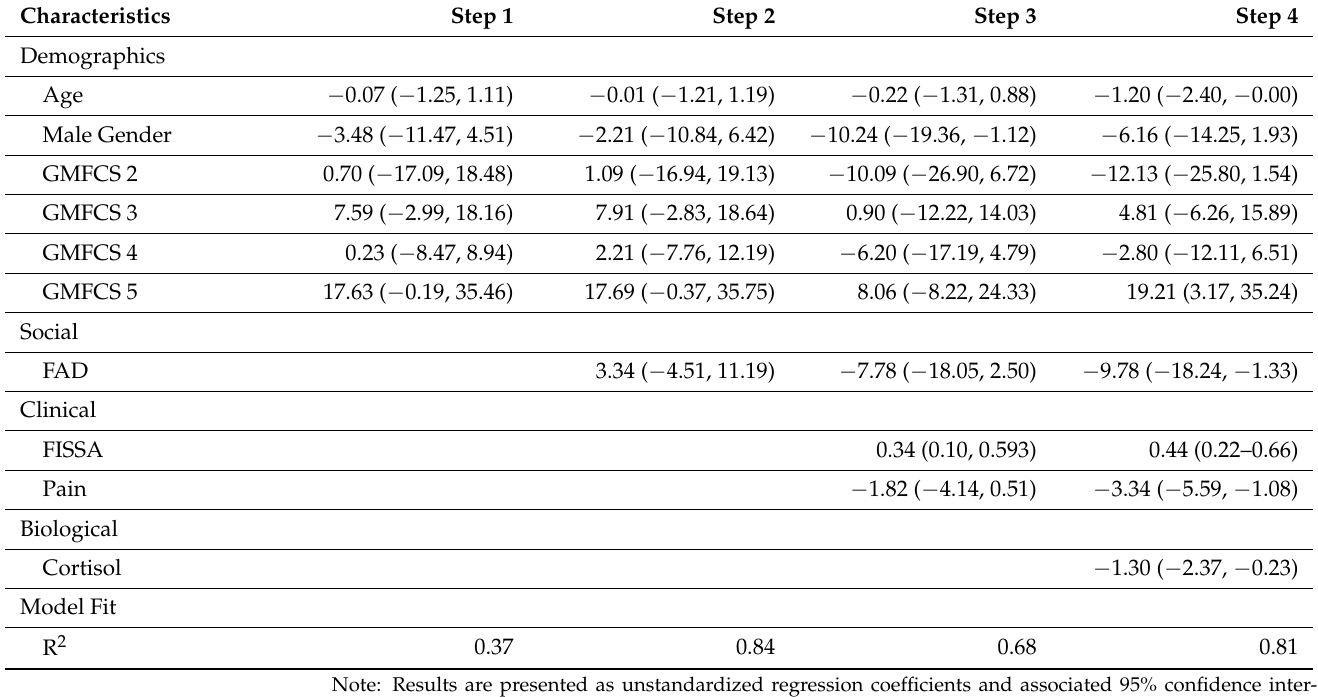
Table 5. Hierarchical regression model